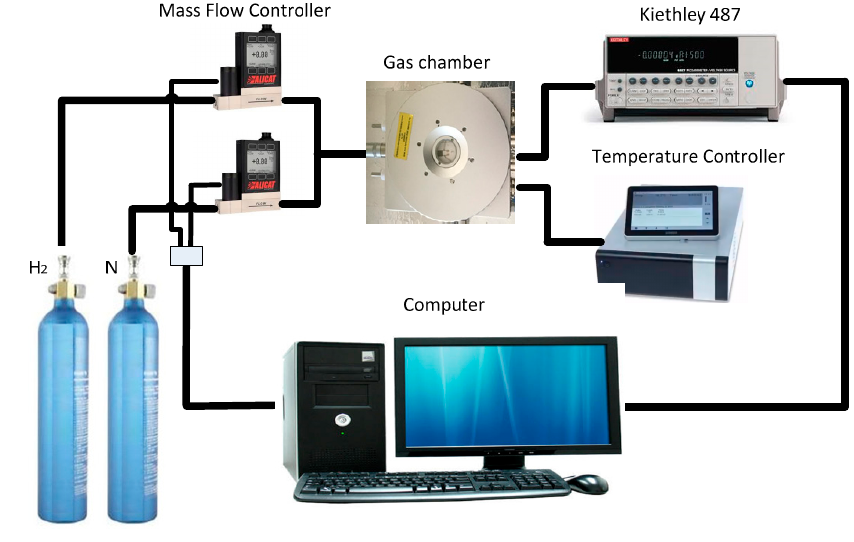
Figure 3. Experimental setup of gas sensing measurement.